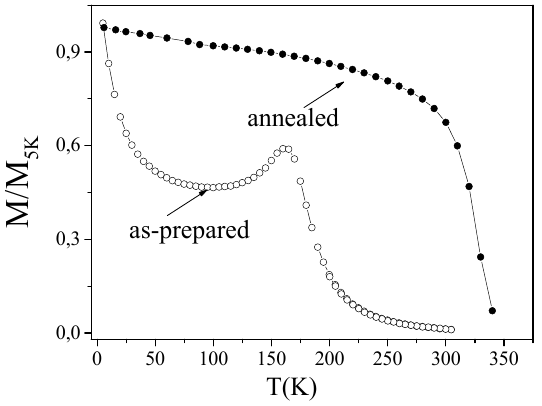
Figure 41. Temperature dependence of normalized magnetization, M/M 5K of as-prepared and annealed Ni-Mn-Ga sample. Reproduced from reference [26], Figure 4a.